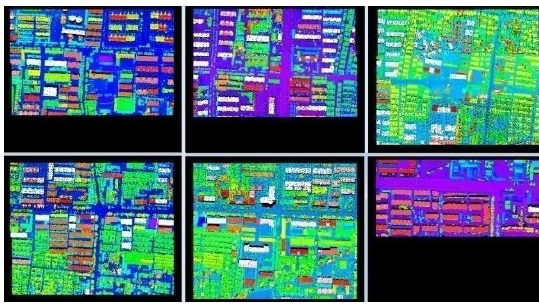
Figure 9. The corresponding LiDAR points